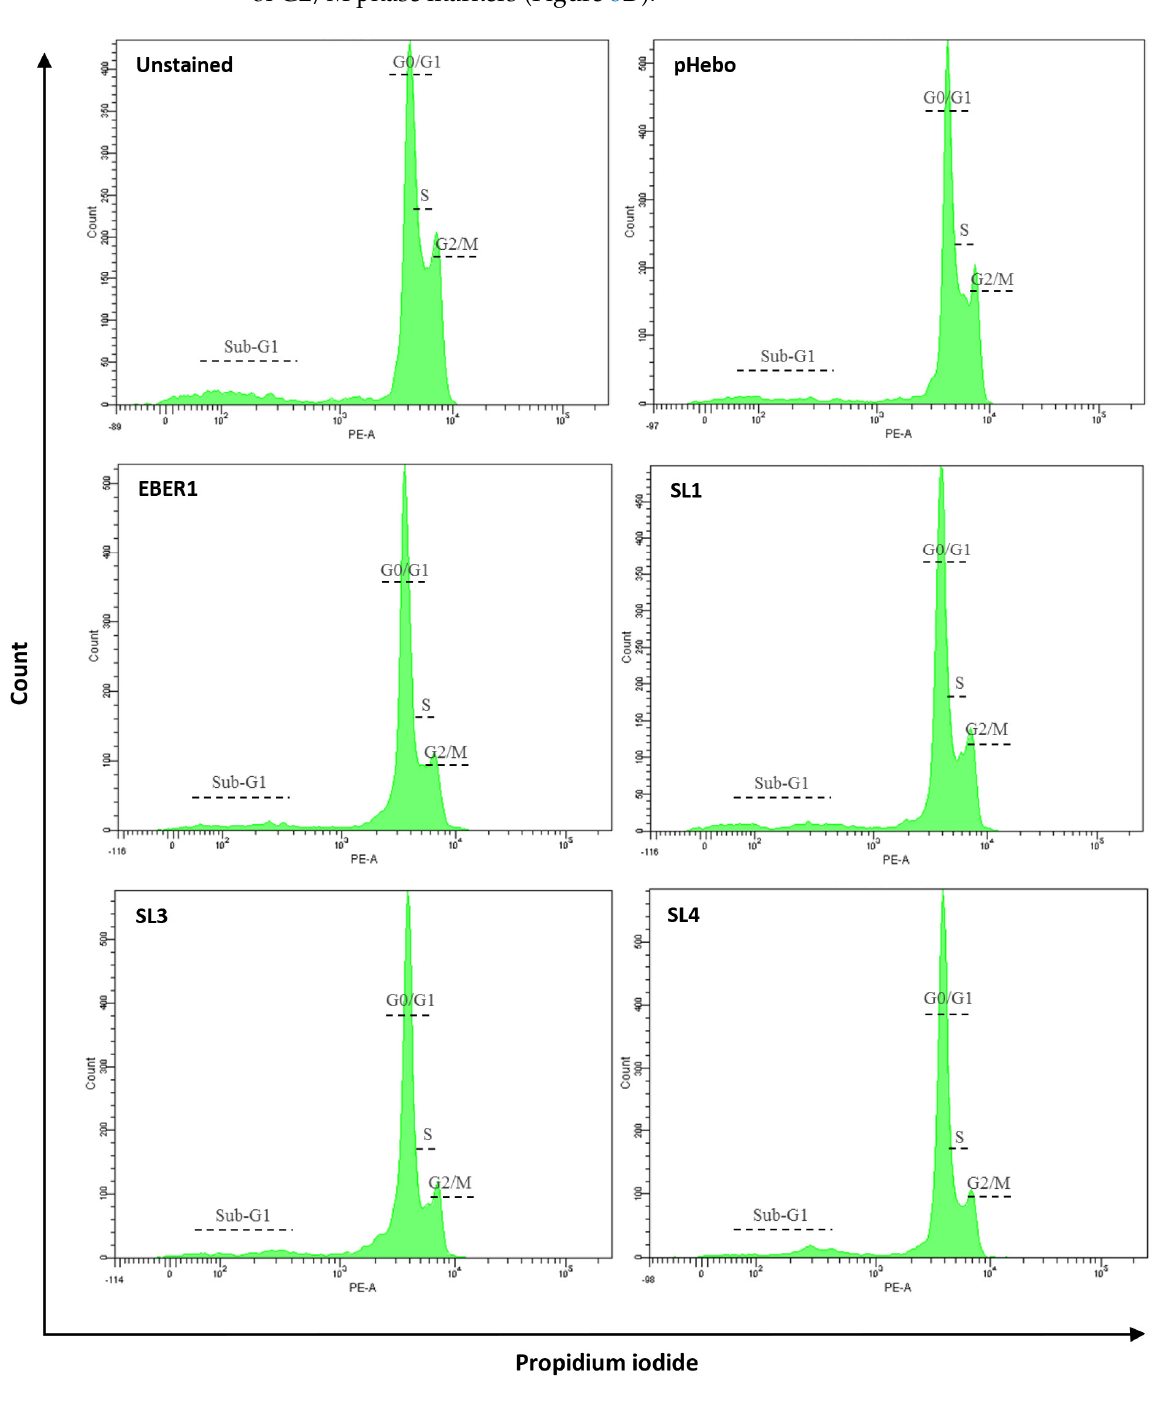
Figure 6. Percentage distribution of cells across the cell cycle . Flow cytometric analysis of cells taken on day 6 of culture and stained with PI. Ten thousand events were recorded per sample. Experiments were performed in duplicate and repeated four times. Table 1. Percentage distribution of DNA contents across the cell cycle . The percentage distribution of DNA contents in the cell cycle phases (G0/G1, S, and G2/M) was analysed using FlowJo. Experi- ments were performed in duplicate and repeated four times. The data are presented as mean of the four independent experiments. The table is colour formatted from red (lower percentage) through green (higher percentage).